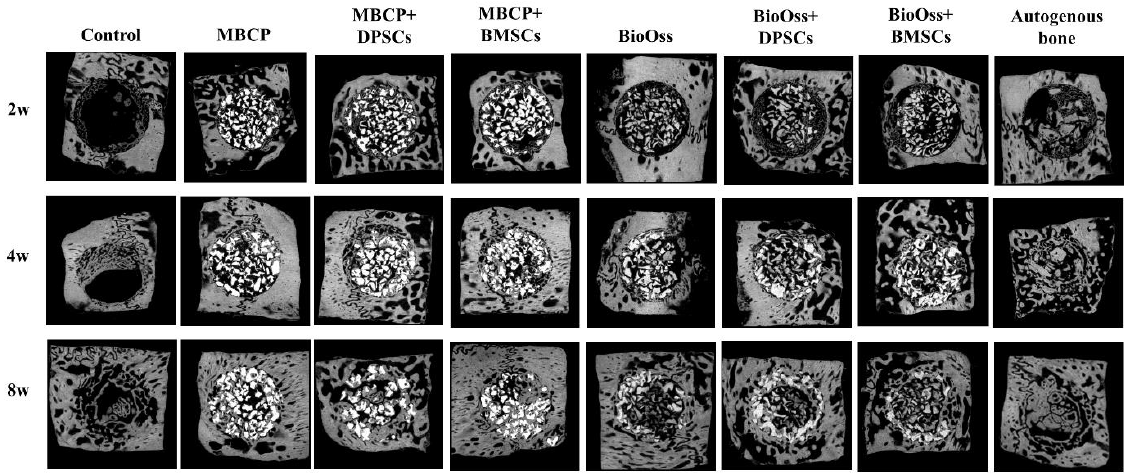
observed among the MBCP+DPSC (23.5% ± 2.6%), MBCP+BMSCs (26.8% ± 1.2%), Bio- Oss+DPSCs (25.1% ± 2.0%), and Bio-Oss+BMSCs (24.0% ± 4.9%) groups. In addition, the MBCP+DPSC and MBCP+BMSC groups exhibited higher BV/TV values than the MBCP-only group ( p < 0.05), whereas the Bio-Oss, Bio-Oss+DPSC, and Bio-Oss+BMSC groups presented no significant differences (Figure 5A).